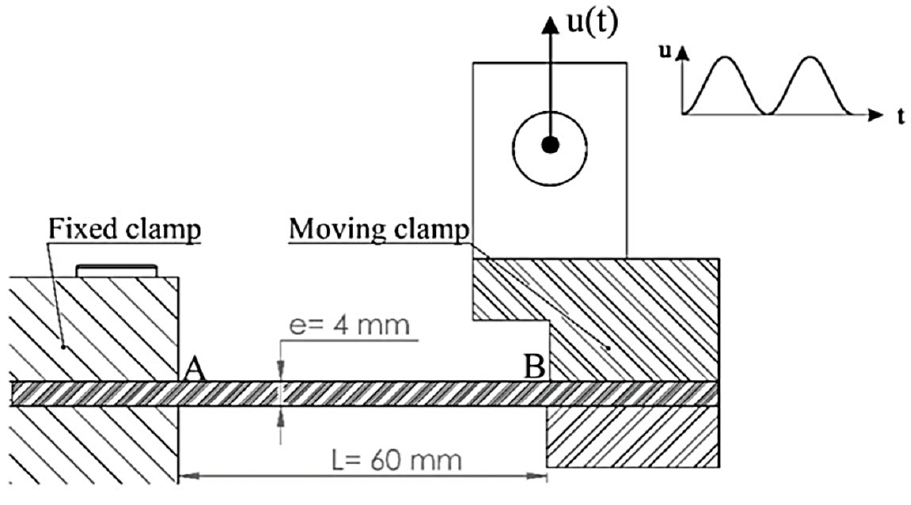
Figure 1. Specimen clamping.